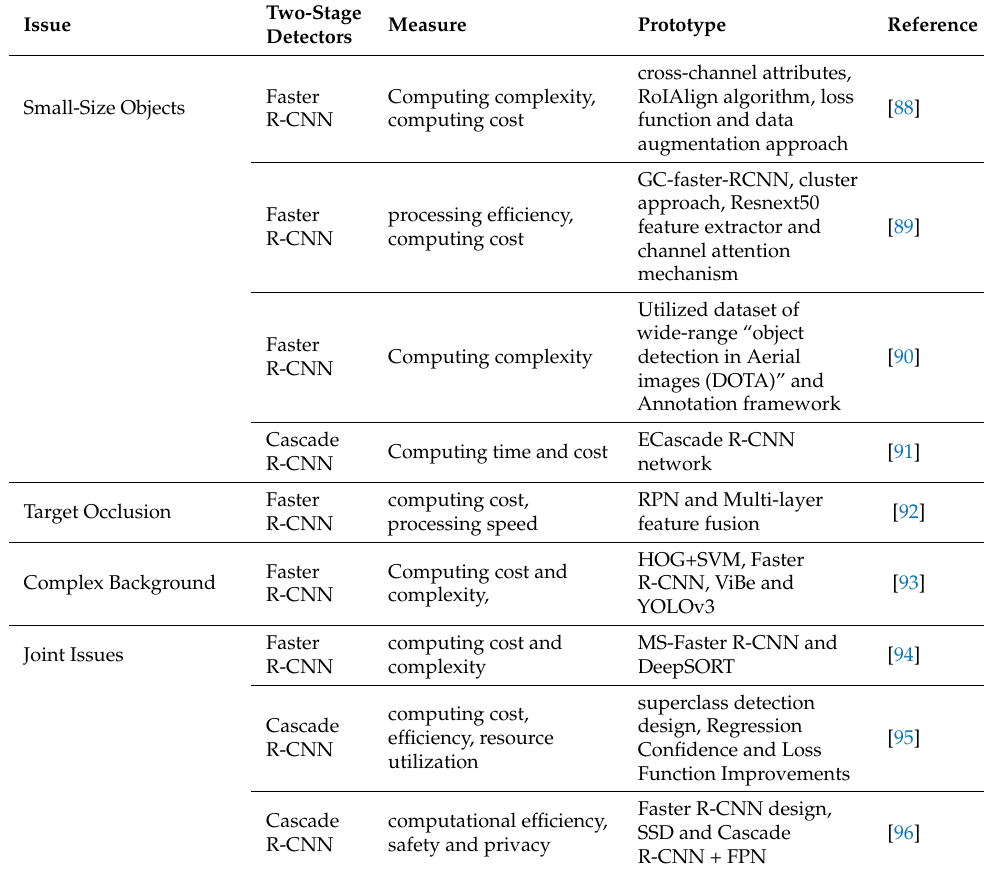
Table 3. Two-stage detectors to tackle the issues in target